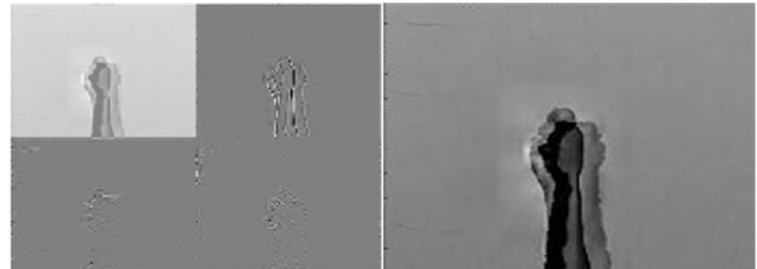
Figure 11. The “min-max” merge strategy performed on two 1st-level DWT coefficients derived from CCD RGB-IR and depth-grayscale hand gesture images ( the left ) and the IDWT-decoded recovery image of the “min-max” merged ( the right ) for VGG-16 CNN deep learning.